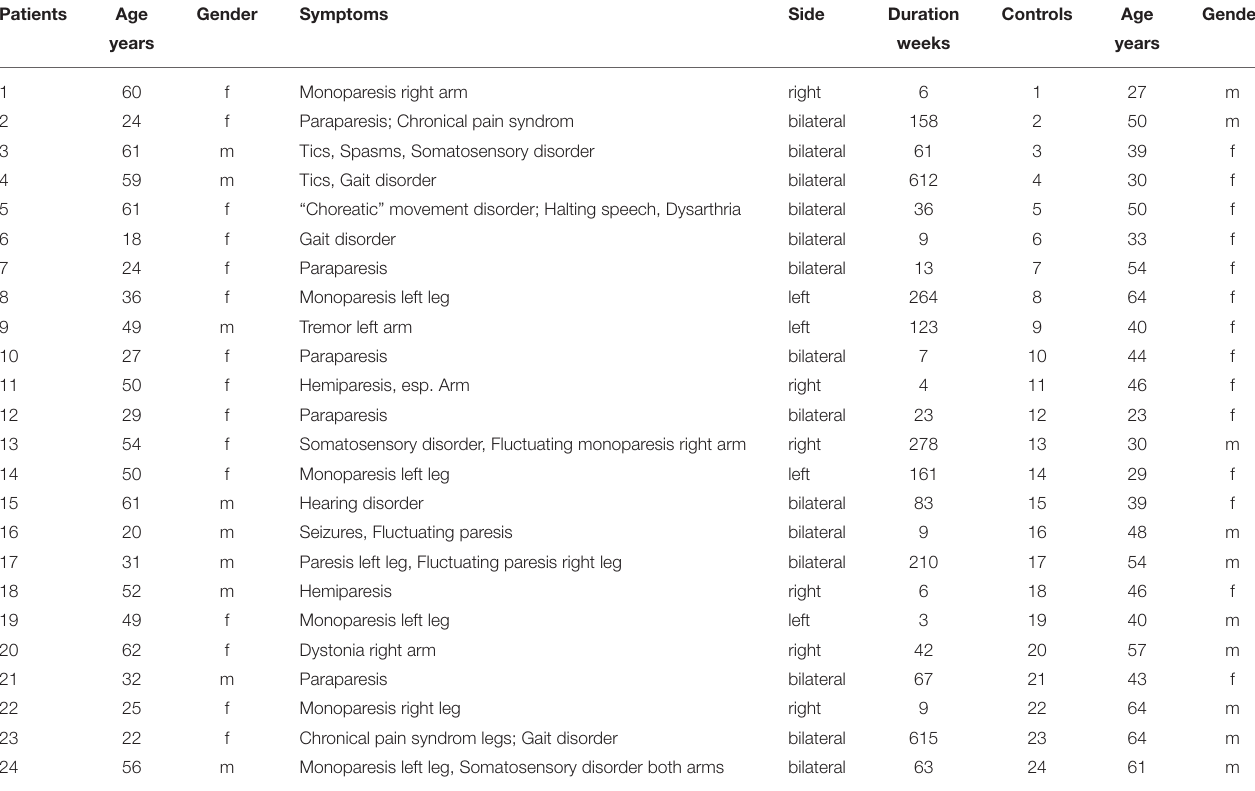
TABLE 1 | Demographic information and clinical symptoms.